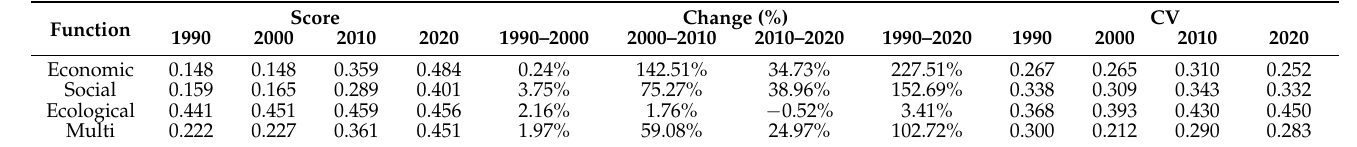
Table 4. Trends in multi-functional changes in cultivated land in the black-soil breadbaskets of Jilin Province, Northeast China, from 1990 to